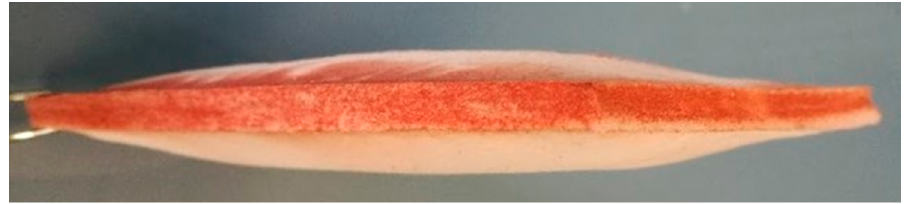
Figure 3. Expanded melamine sponge after compressed curing.